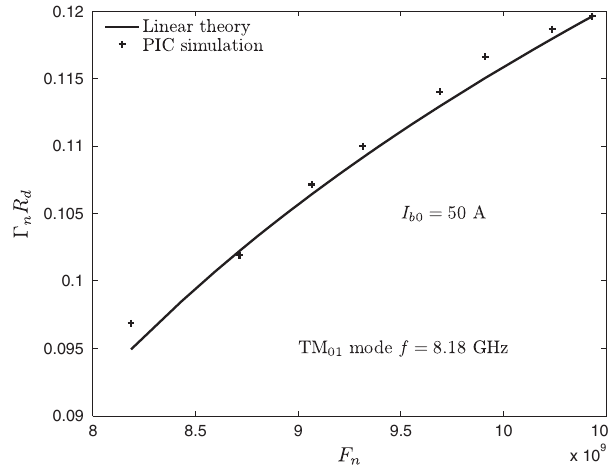
FIG. 19. Normalized growth rates for the TM 01 mode as a function of coupling parameter, F